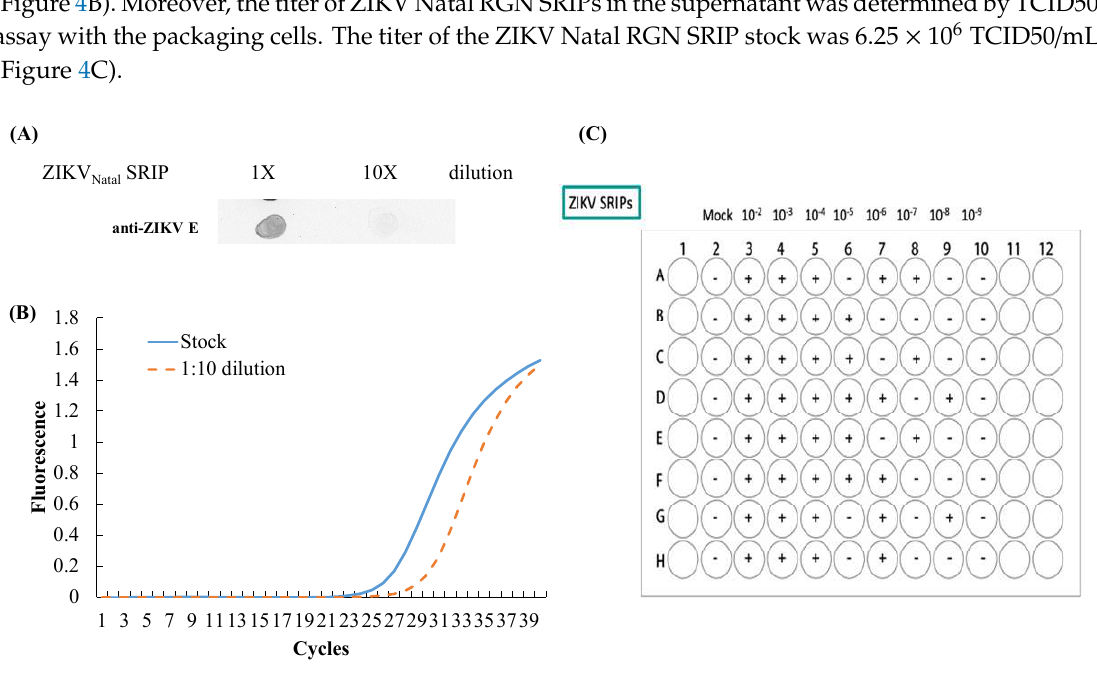
Figure 4. Antigenicity and quantitative analysis of ZIKV Natal RGN single-round infectious particles (SRIPs). The antigenicity, relative viral genome levels, and titer of SRIPs collected from the supernatant of the packaging cells transfected with the ZIKV Natal RGN replicon were analyzed using dot blot ( A ), real-time RT-PCR ( B ), and TCID50 ( C ) assays, respectively.